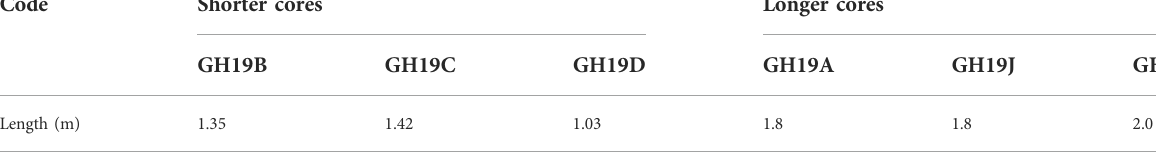
TABLE 1 The actual length of the shorter and longer cores.